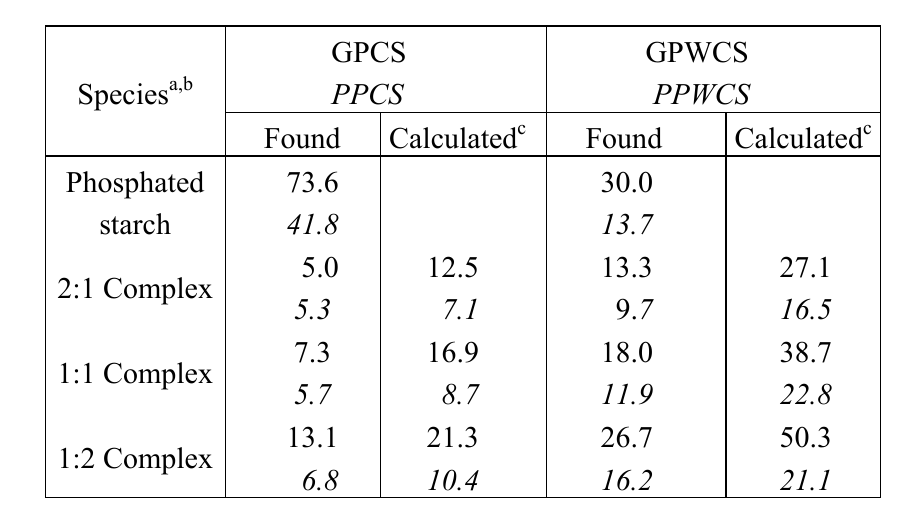
Table 3. Water binding capacity of GPCS, PPCS, GPWCS and PPWCS and their casein complexes [g/g of dry residue] at 60 o